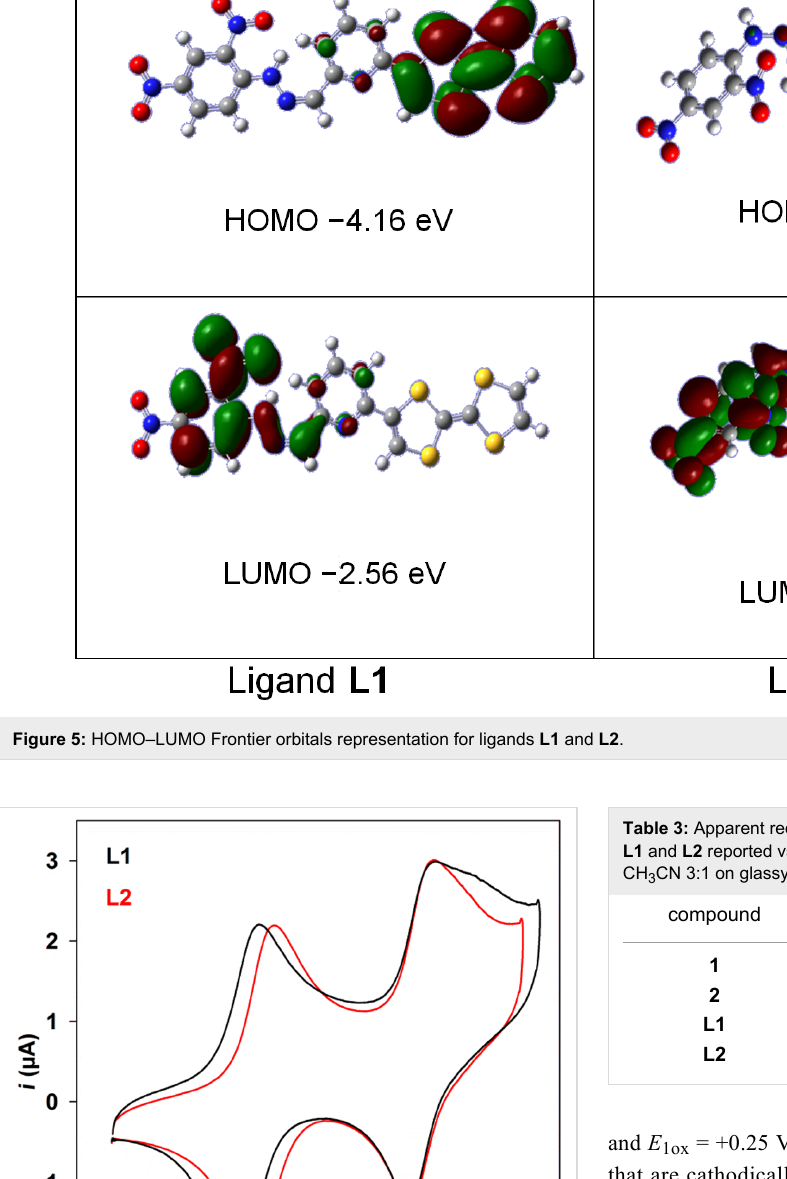
compared with E 1ox of 1 , indicating a strong π -electron conju- gation in precursor 2 . As for 1 and 2 , ligands L1 and L2 show two reversible oxidations at E 1ox = +0.20 V, E 2ox = +0.70 V